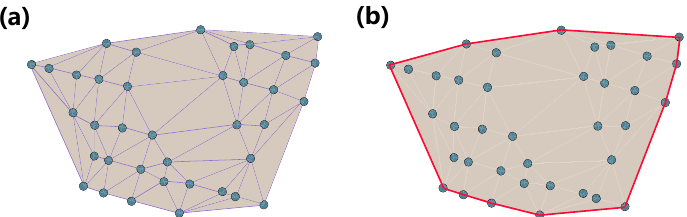
Figure 7. Triangulation generation and boundary extraction of sparse point cloud based on Gra- ham algorithm: ( a ) represents triangular mesh generation; ( b ) represents boundary extraction.